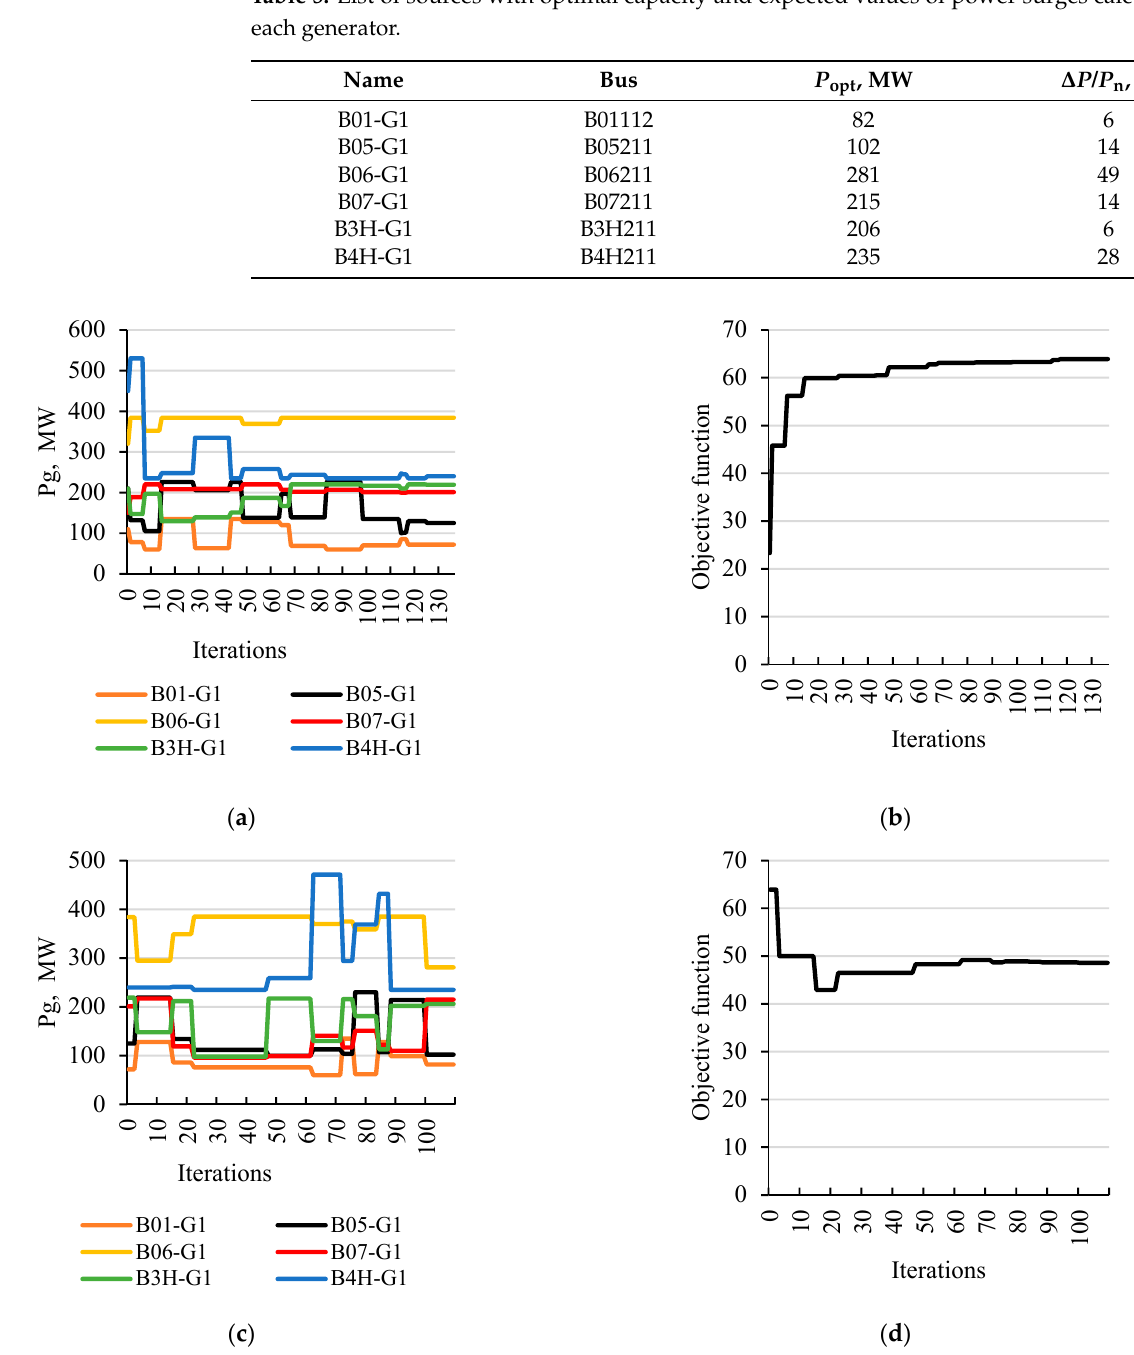
Figure 8. The process of determining the maximum SPA for case 3; ( a ) changing the generation distribution to determine the maximum (global) SPA; ( b ) a graph of changes in the value of the objective function (maximum SPA); ( c ) changing the generation distribution to determine a maximum safe SPA; ( d ) graph of changes in the value of the objective function with the penalty function (maximum safe SPA).